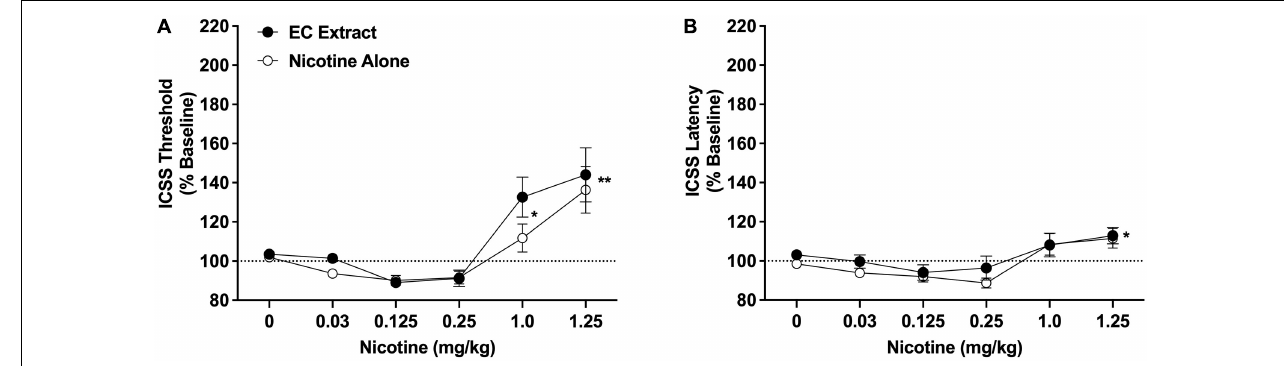
FIGURE 4 | Total MAO activity (expressed as % control) in brain homogenate following in vitro application of various concentrations of (A) TCP or (B) nicotine alone, CS Extract, or EC extract. Panel (C) shows MAO-A and MAO-B activity (% control) following in vitro application of various concentrations of CS extract. Data in panels (A–C) represent the mean ± SEM across 2–5 replications. Panel (D) shows total MAO activity (% control) in rat brain measured ex vivo following s.c. injection of saline or 1.25 mg/kg nicotine alone, CS extract, or EC extract, or i.p. injection of 3.0 mg/kg TCP (positive control). **Different from saline, p < 0.0001. Absolute fluorescence values (relative fluorescence units, mean ± SEM) for controls for panels (A–D) were 397,509 ± 21,044, 349,888 ± 40,700, 365,544 ± 68,497, and 357,593 ± 16,850, respectively.